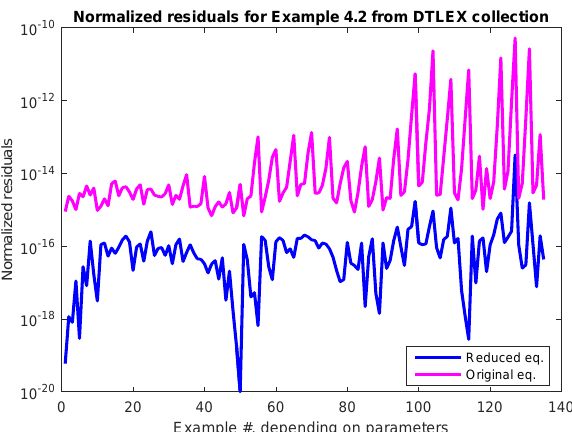
Figure 20. Normalized residuals for reduced and original Lyapunov equations for DTLEX 4.2 series of examples, using the ArLyap solver; tolerance ε 2